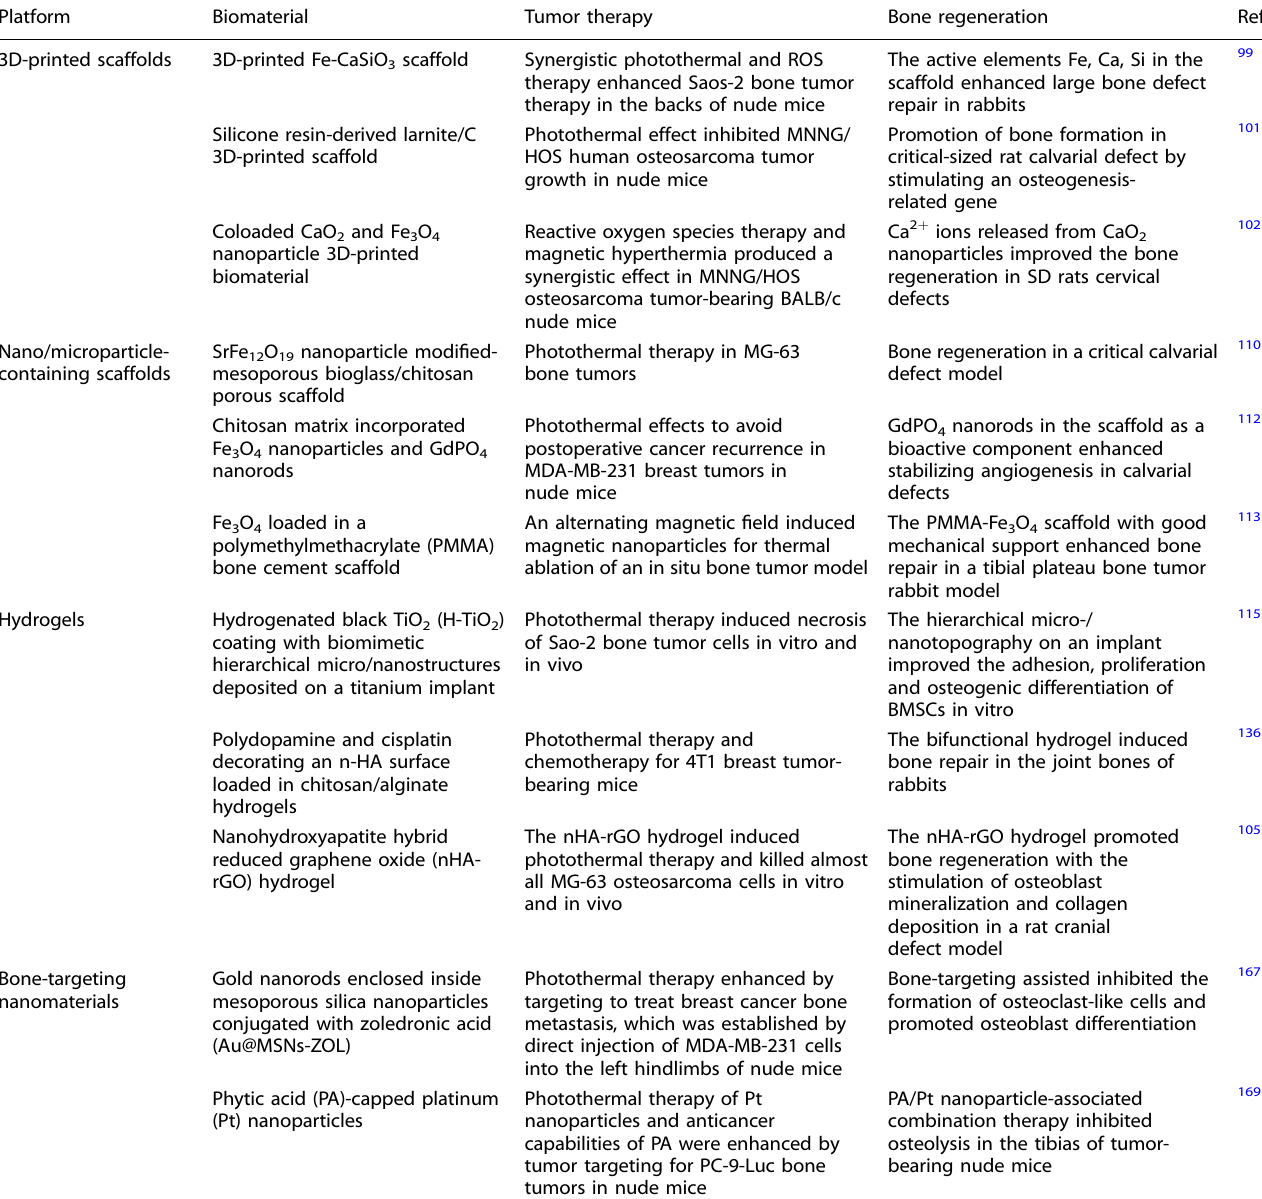
Table 1. Examples of bifunctional biomaterials mainly include 3D-printed scaffolds, nano/microparticle-containing scaffolds, hydrogels, and bone- targeting nanomaterials in tumor therapy and bone regeneration